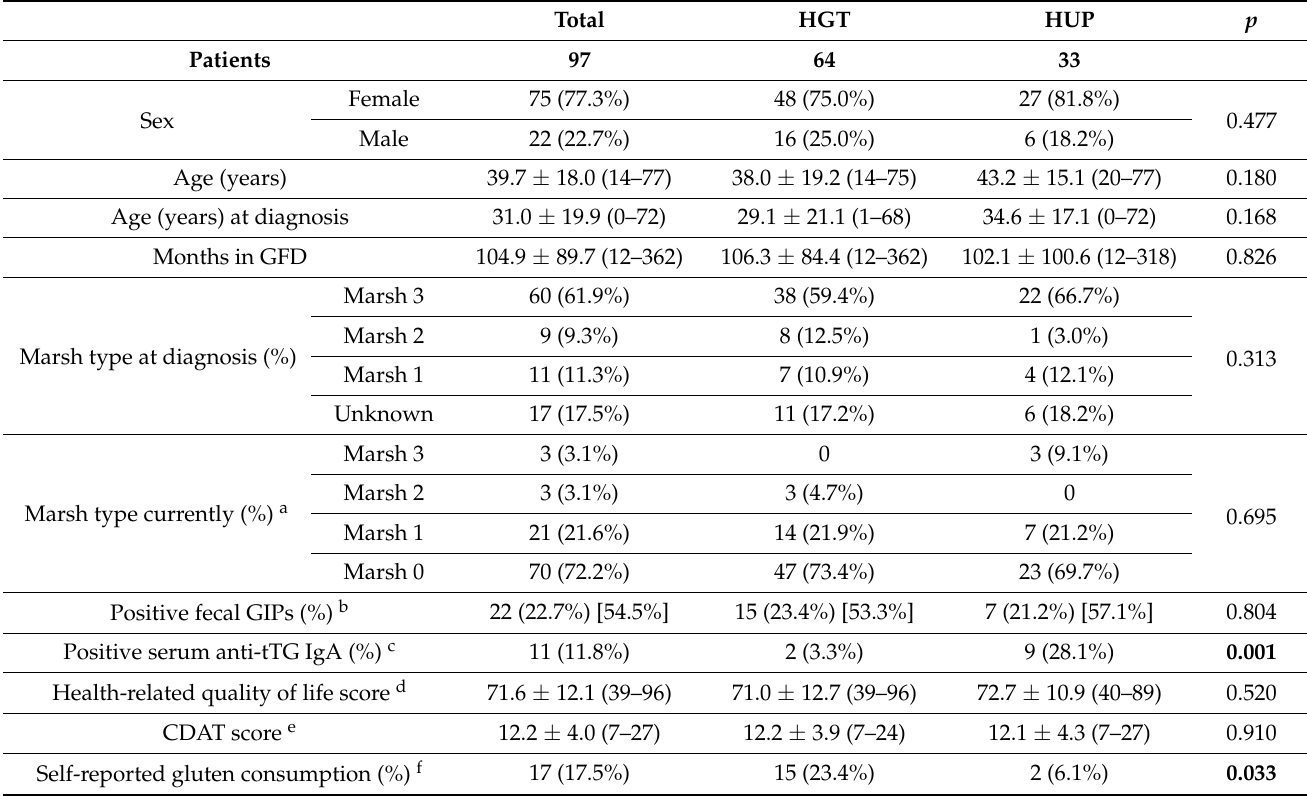
Table 1. Demographic and clinical characteristics of patients included in the study and statistical comparison between both recruiting